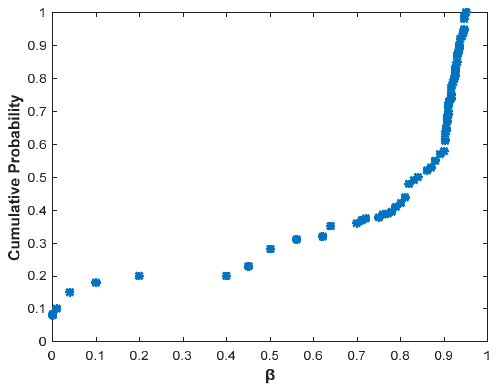
Figure 5. The β value for the links.